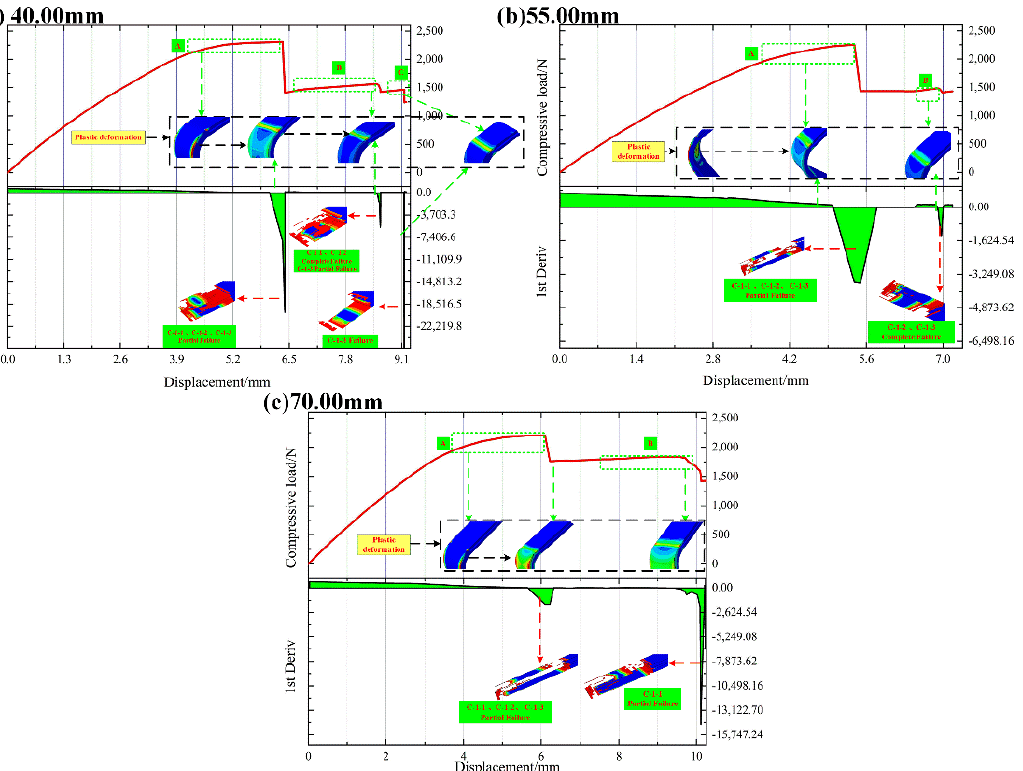
Figure 14. The load–displacement curve and its first derivative curve of the compression simulation of the L-joint with different bonding lengths: ( a ) 40.00 mm, ( b ) 55.00 mm and ( c ) 70.00 mm and (A) The first load stabilization stage; (B) The second load stabilization stage; (C) The third load stabilization stage. Table 4. The comparison of the ultimate loads and corresponding displacements of different L-joint experiments and simulation